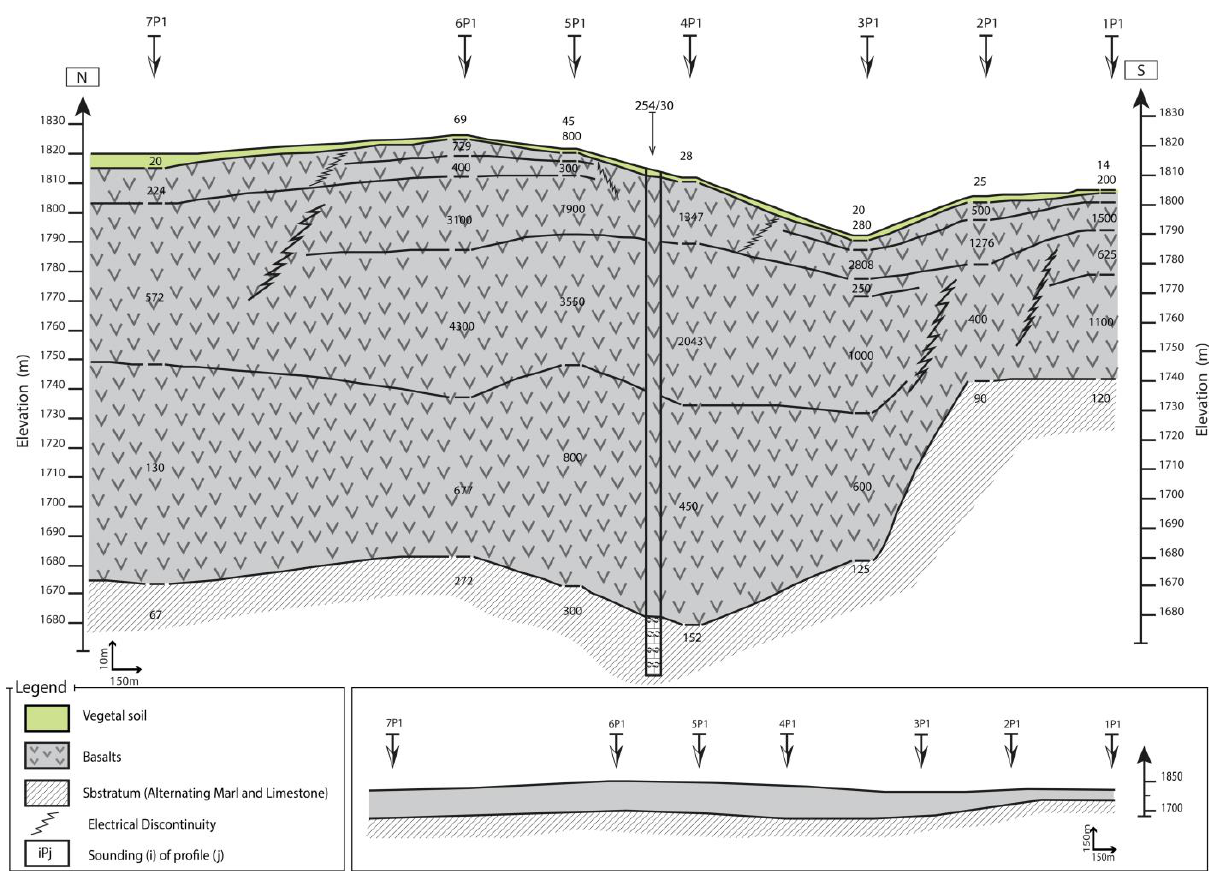
Figure 6. GS1 geoelectrical section of profile 1.